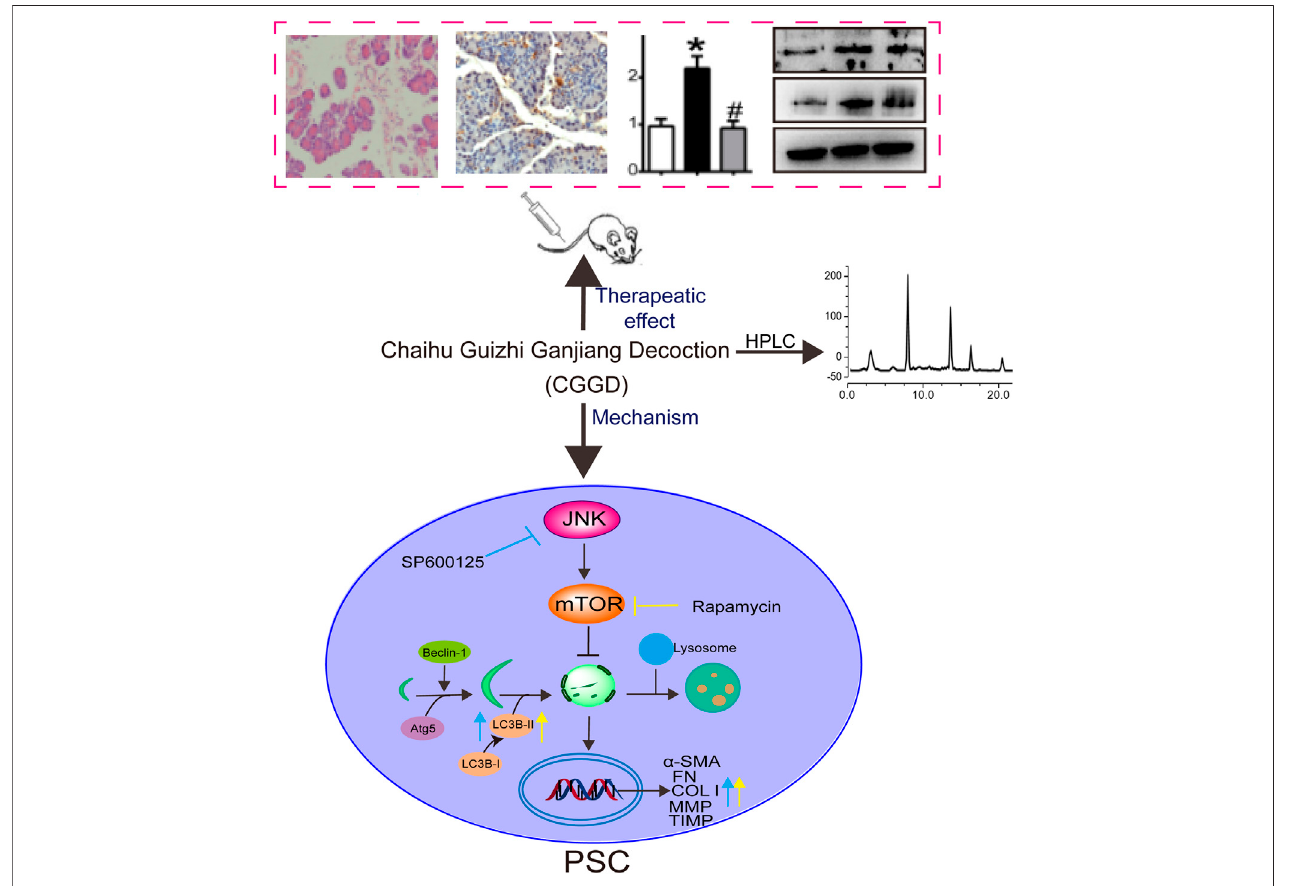
FIGURE 7 | Graphical abstract of CGGD-ameliorated pancreatic fi brosis through deactivation of PSC by inhibiting autophagy via the JNK/mTOR pathway.